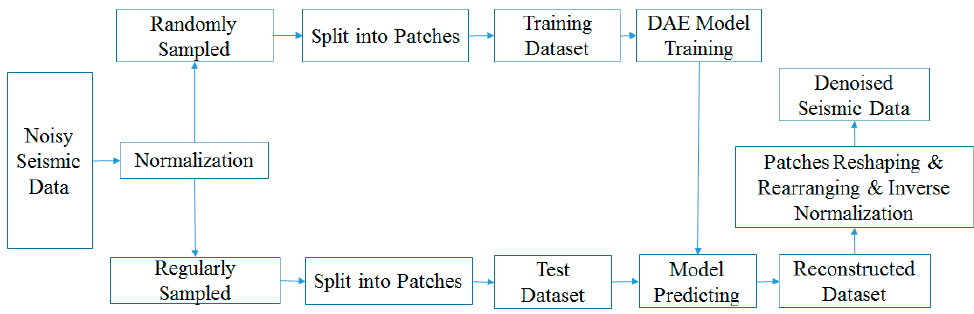
Figure 1. Proposed workflow.